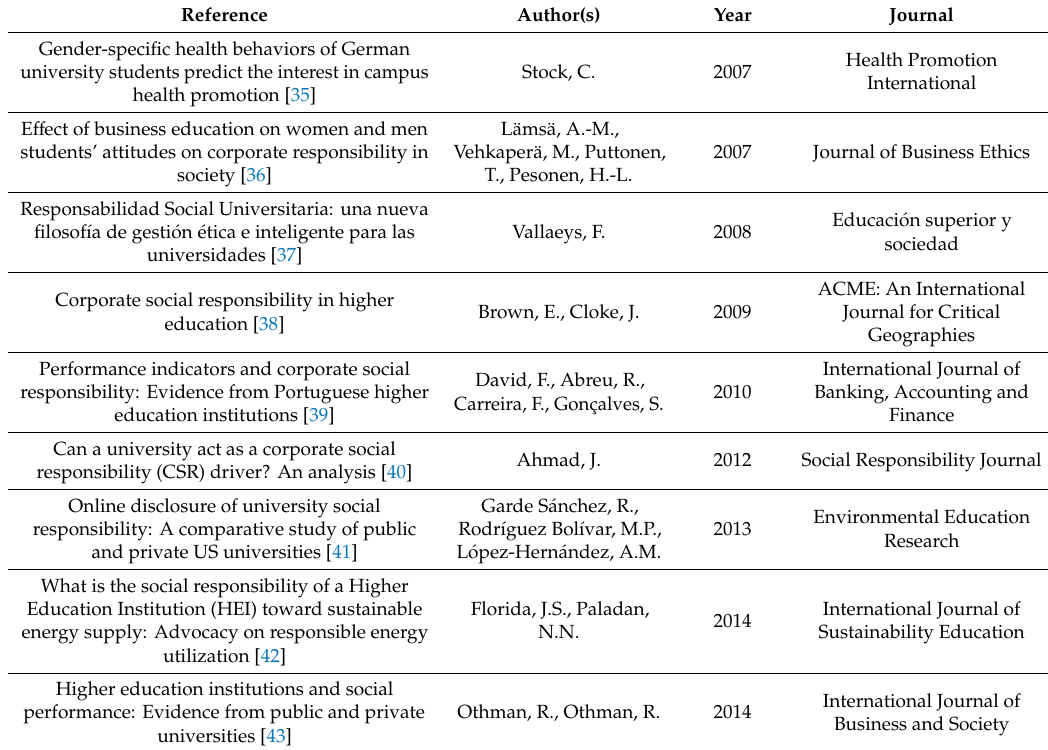
Table 1. Main literature revised of the research